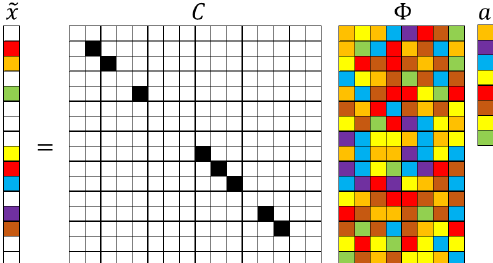
Figure 3. Schematic of GPOD formulation for sparse recovery. The numerical values represented by the colored blocks: black (1), white (0), and color (other